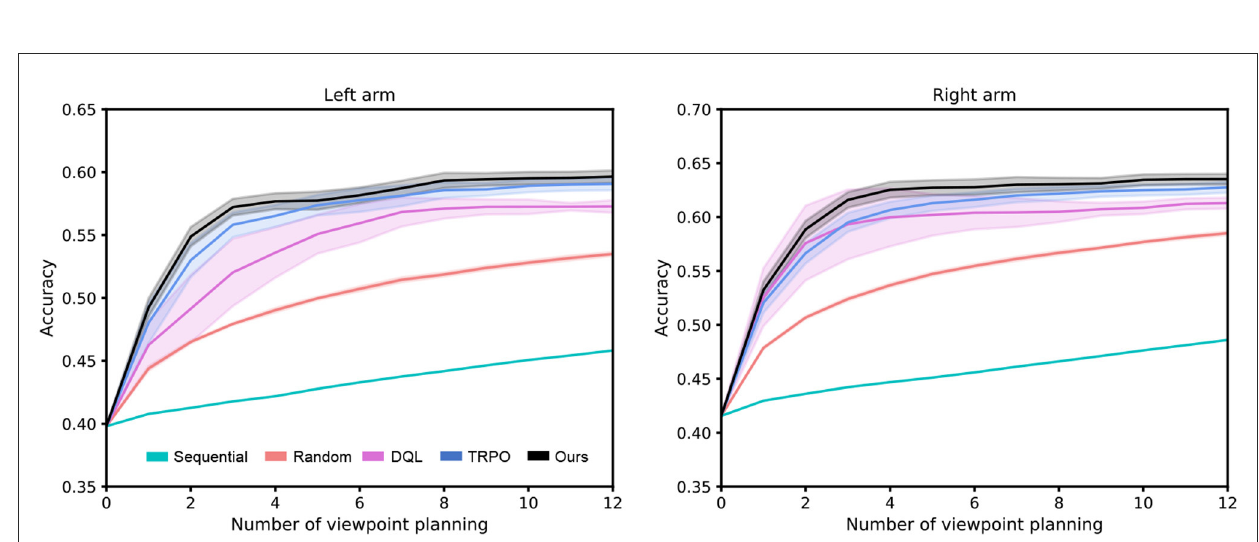
FIGURE5 Performance comparison between our presented deterministic continuous VP approach and several competing methods. The shaded region represents the standard deviation of the average evaluation over 10